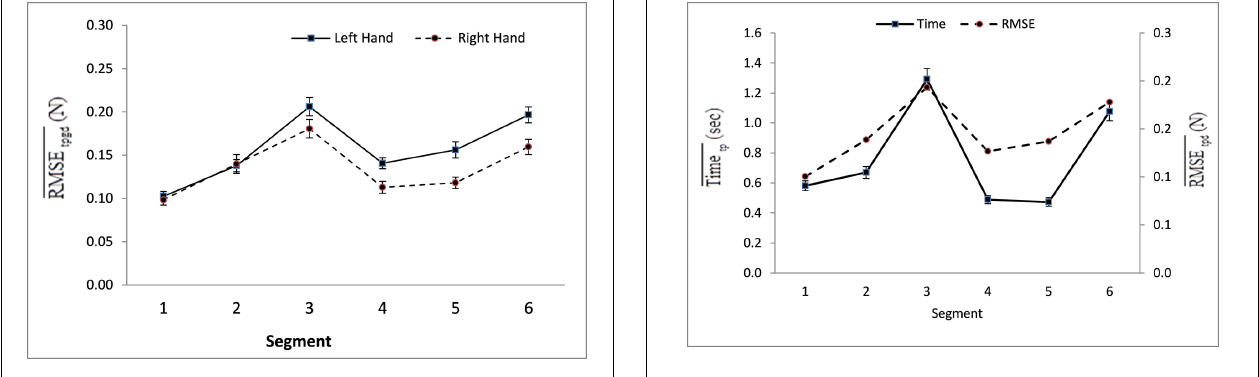
FIGURE 5 | MeanTaskTime and standard errors by segment as averaged over all trials (t) of all participants (p) in all groups on all practice days (d). The arithmetic mean time and the mean RMSE score for Segments 3 and 6 have a statistically large significant difference from those mean scores of all other segments ( p < 0.01).